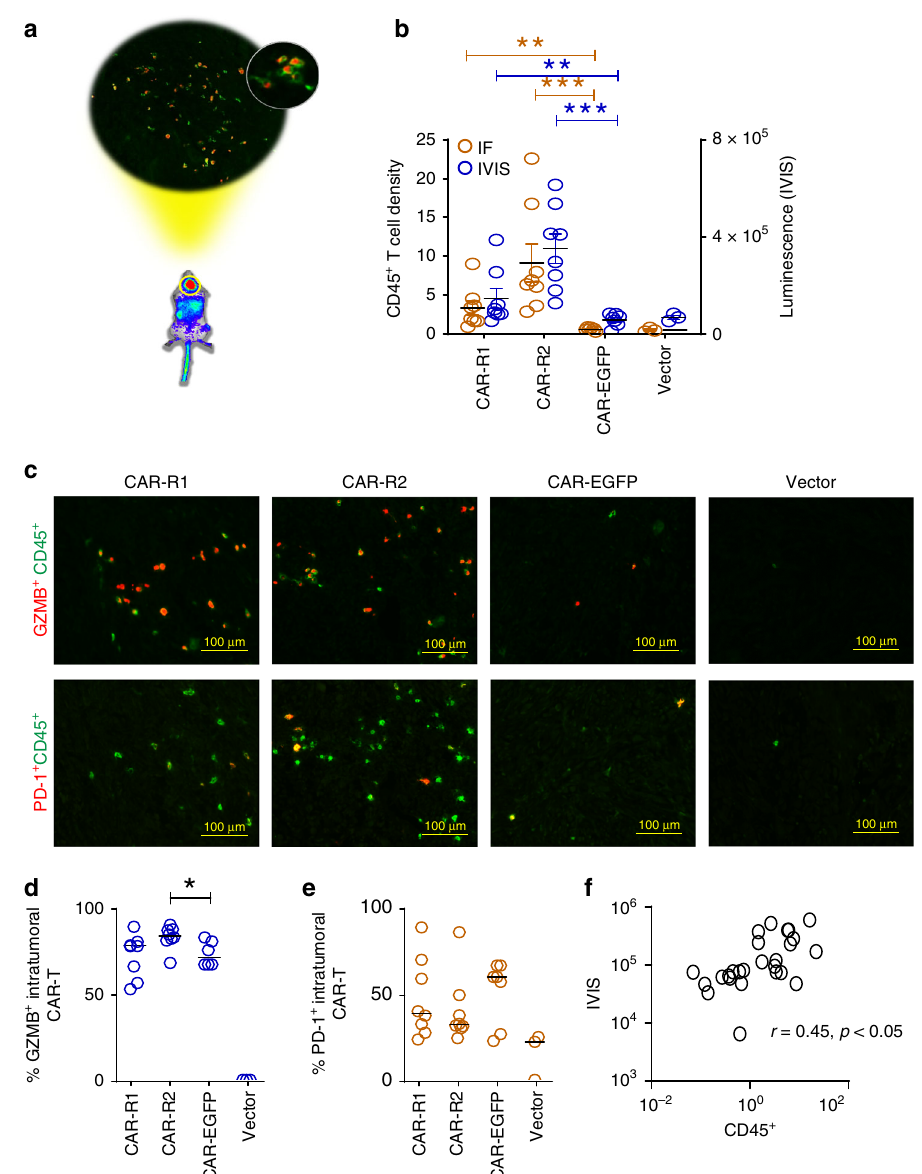
Fig. 4 Increased intratumoral CAR T cells with activation phenotype in the 8R70 CAR T-treated tumors. a A schema of the intratumoral T-cell phenotype. A similar approach as described in Fig. 3a was used. The T cells for the CAR transduction were derived from a GBM patient. Two days after the CAR T-cell transfer, IVIS imaging was carried out for con fi rming the existence of CAR T cells in the tumor area, and then the tumors were dissected from the animals, followed by immuno fl uorescence staining for phenotype analysis of tumor-in fi ltrating CAR T cells. b Intratumoral CAR T-cell in fi ltration in these treatment groups. The readouts of intratumoral CAR T cells measured by CD45 + CAR T-cell density (numbers/mm 2 ) and luminescence signals in ROI quanti fi ed by IVIS from the same animal are shown (mean ± SEM, the Mann – Whitney U test). c The phenotype of the intratumoral CAR T cells. The tumor sections were stained with two antibodies against GZMB (red, upper panel) and CD45 (CAR T cells, green), or PD-1 (red, lower panel) and CD45 (green). Representative images are displayed for the treatment groups. d , e Quanti fi cation of the frequency of GZMB + and PD-1 + intratumoral CAR T cells. The cell density of CD45 + , GZMB + , and PD-1 + cells (numbers/mm 2 ) in the IF images were acquired from the entire tumor mass. The percentage of CD45 + GZMB + and CD45 + PD-1 + CAR T cells were, respectively, calculated based on the cell density of GZMB or PD-1 over CD45. The bars indicate the median values. f A correlation between IF and luminescence signals. The correlation was determined by Pearson correlation. * p < 0.05, ** p < 0.01, *** p <